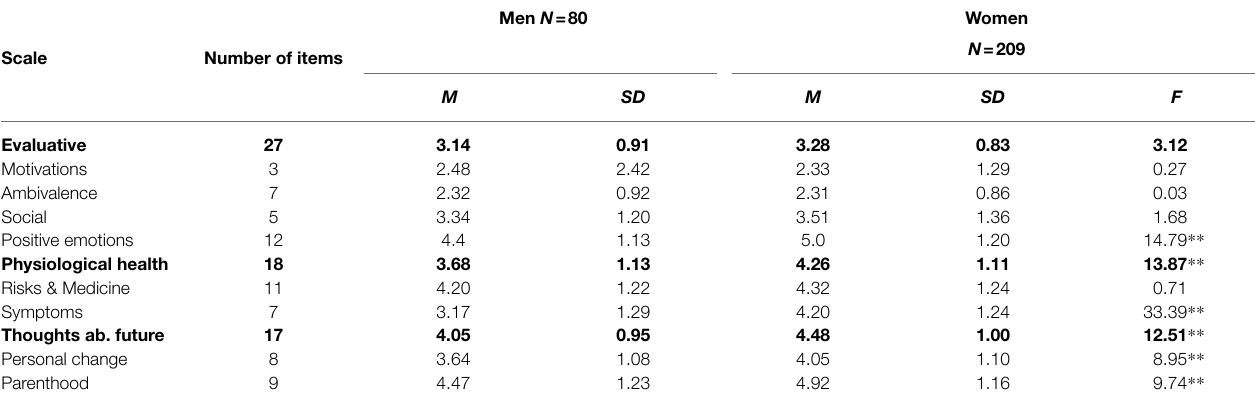
TABLE 5 | Means, standard deviations, and F-scores of the scale scores for men and non-women participants. Scale Number of items